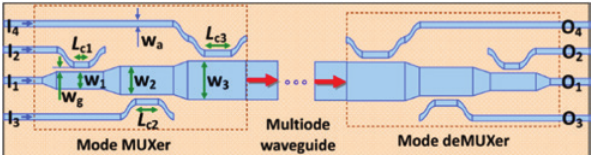
Figure 5: A four-channel mode (de)multiplexer based on cascaded ADCs